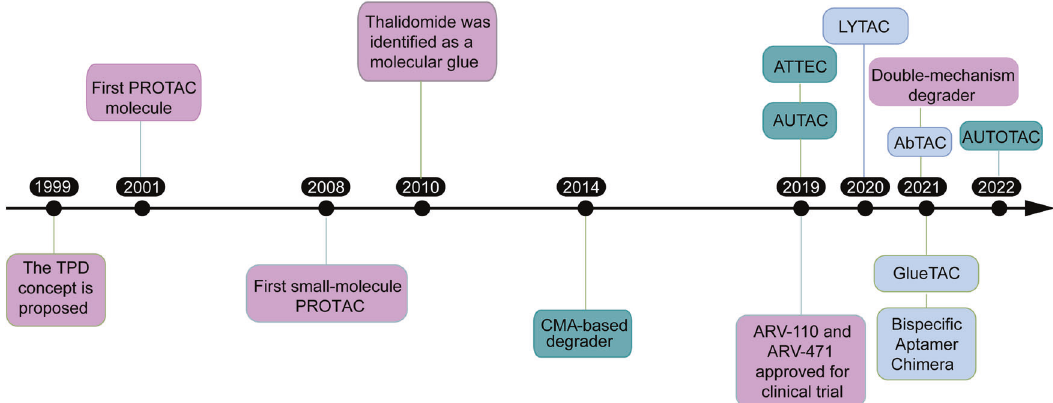
Fig. 3 Representative events in the TPD development. Purple: technologies related with UPS-based technologies; light blue: technologies related with the endosome-lysosome pathway; dark blue: technologies related with the autophagy-lysosome pathway Table 1. Different TPD